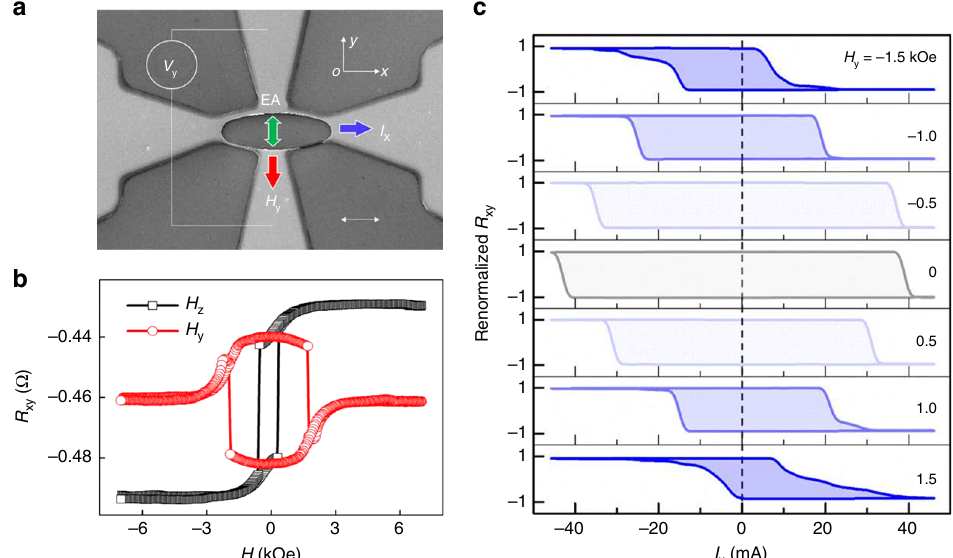
Fig. 4 Switching characteristics as applying a bias fi eld along the EA. a Scanning electron microscopy image of the measurement setup. Scale bar: 10 μ m. b R H H I xy as functions of z and y . c x dependence of renormalized